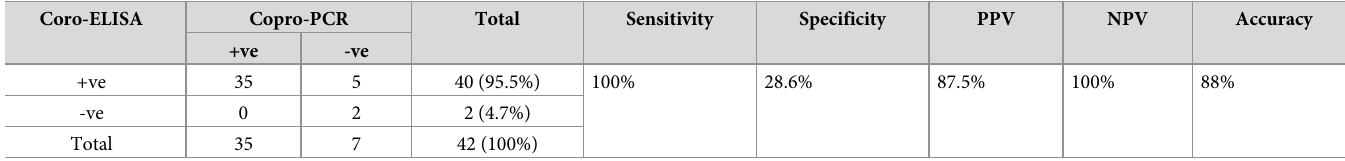
always detected in stool examination. Therefore, an immunological and molecular diagnosis will provide a supportive diagnostic tool [9, 13]. The present study included 42 patients clinically suspected to be infected with C . philippi- nensis as they were suffering from manifestations similar to those reported by Cross (1992) and Intapan et al. (2017), Attia et al. (2012), Limsrivilai et al. (2014) [1, 9, 17, 21] . Micro- scopic examination showed low positivity, which could be attributed to the low parasitic load and intermittent shedding of the parasite into the stool [21] . This coincides with other previ- ous studies conducted in Egypt by Amin et al. (2011) and Ali et al. (2016) [22, 14]. Concern- ing the presence of Charcot-Leyden crystals, in the present work, their number correlated with the severity of the infection and the number of eggs detected, which supported the diagnosis as stated by Cross (1992) and Saichua et al. (2008) [1, 23]. In this study, we developed a capture ELISA using crude worm antigen anti-rat and anti- rabbit hyperimmune sera. These results indicate the superiority of the copro-ELISA to copro- scopy, suggesting that the microscopic examination underestimates the real prevalence of C . philippinensis infection. Although coproantigen detection by ELISA showed very high Table 4. Comparative results of copro-ELISA and copro-PCR in the diagnosis of C . philippinensis infection among the study cases. Coro-ELISA Copro-PCR Total Sensitivity PPV NPV